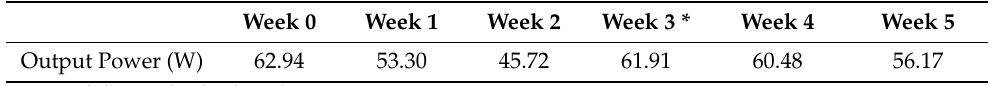
Table 7. Current measured at weekly intervals without